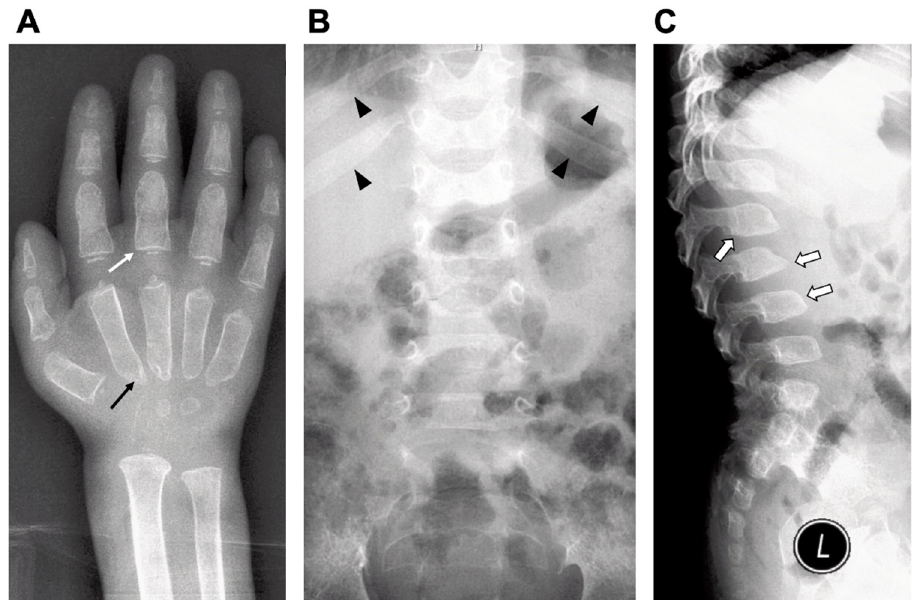
Figure 4. Radiographic findings of a MPSPS patient at age of one-year and nine-month. Characteristics of dysostosis multiplex: ( A ) bullet-shaped phalanges (white arrow) and the metacarpal pointing (black arrow); ( B ) widening of anterior ribs (oar-shaped ribs) (arrowhead) and ( C ) vertebral dysplasia with round- and hooked-shape vertebral bodies (open arrow).